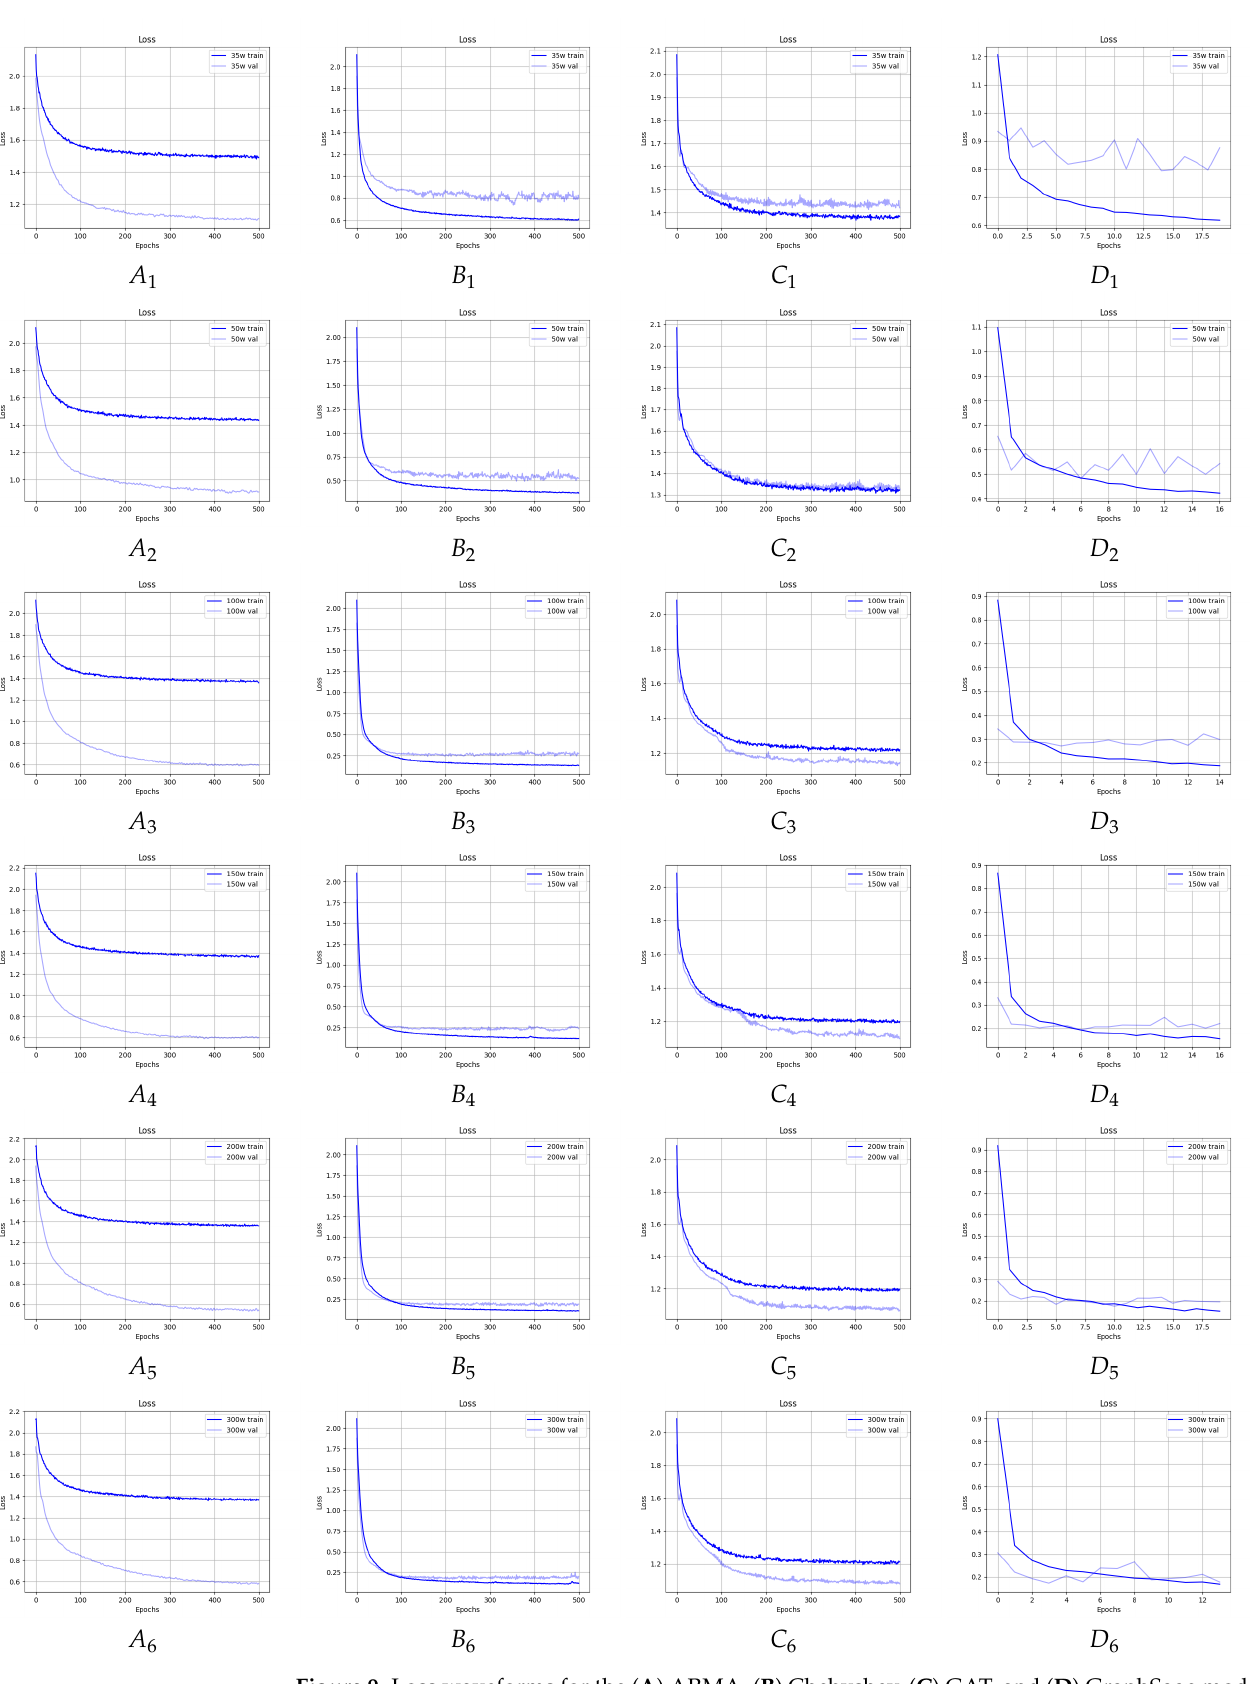
Figure 9. Loss waveforms for the ( A ) ARMA, ( B ) Chebyshev, ( C ) GAT, and ( D ) GraphSage models, which considered: 1. 35, 2. 50, 3. 100, 4. 150, 5. 200, and 6. 300